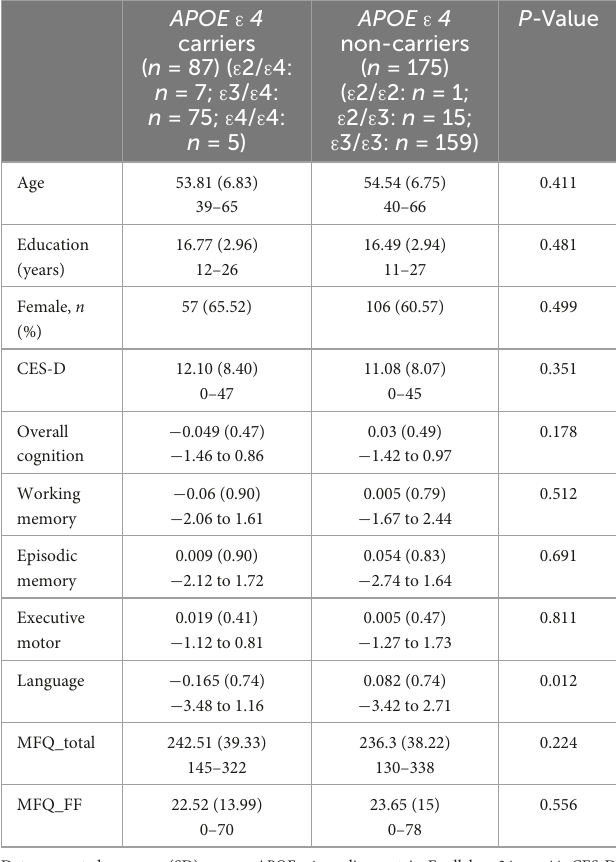
TABLE 1 Characteristics of APOE ε 4 carriers vs. APOE ε 4